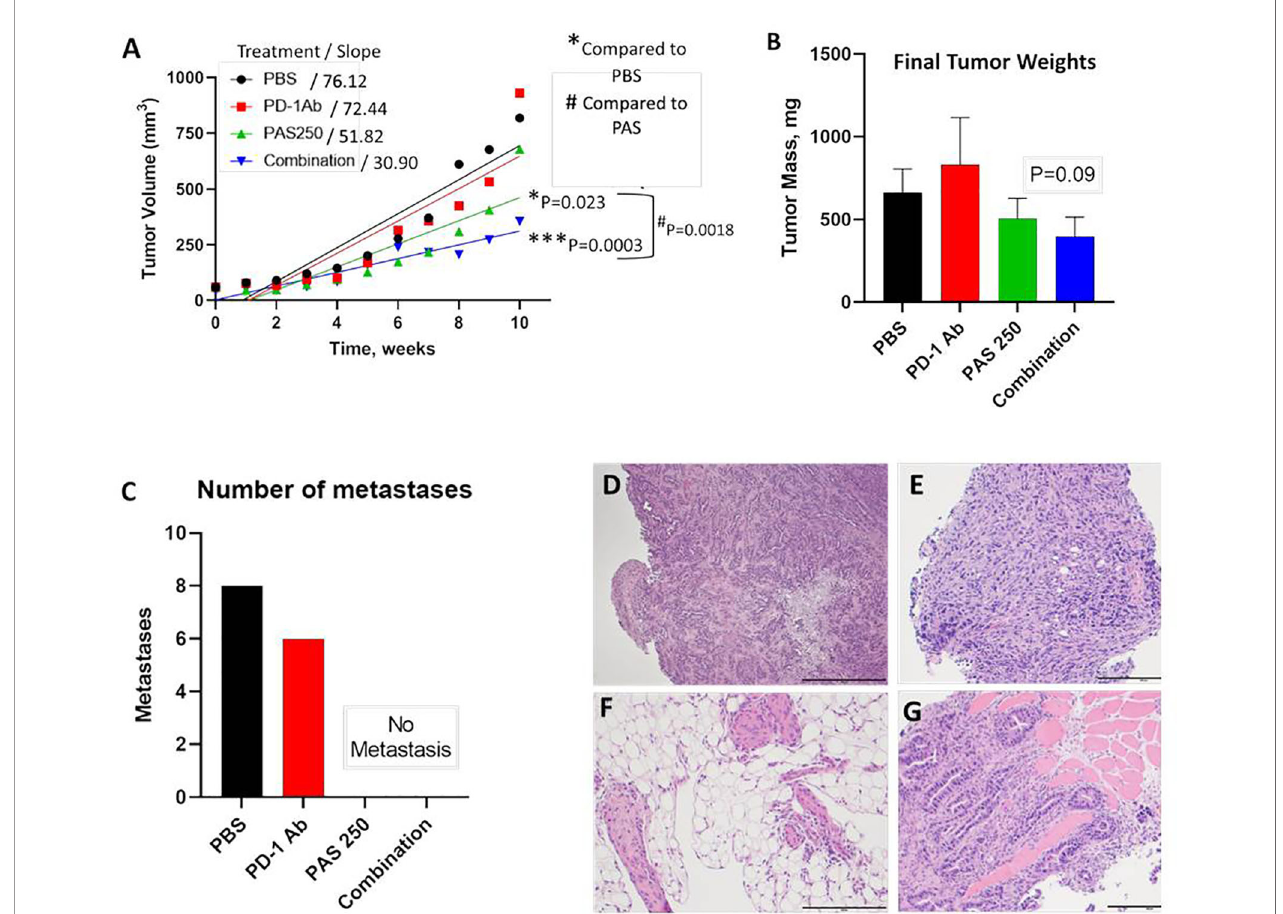
FIGURE 3 | PAS vaccination alone or in combination with PD-1 Ab inhibits growth and metastases of YTN gastric cancer tumors in mice. (A) YTN tumor volumes over time for each treatment group and respective slope of the line are shown. PD-1 Ab monotherapy did not alter rate of YTN tumor growth compared to PBS- treated controls. Tumors of mice treated with PAS monotherapy (P = 0.023) or in combination with PD-1 Ab (P = 0.0003) signi fi cantly reduced tumor growth in mice compared to PBS control treated mice. Tumors of mice treated with both PAS and the PD-1 Ab exhibited signi fi cantly smaller tumors compared to PAS monotherapy (P = 0.0018). (B) Final tumor mass ex vivo showed a reduction in size in mice treated with PAS in combination with the PD-1 Ab (P = 0.09). (C) Number of metastases for each treatment group demonstrates that metastases were only observed in Control (PBS-treated) mice and in mice treated with PD-1 Ab. No metastases were found in mice treated with PAS monotherapy or PAS in combination with the PD-1 Ab. (D – G) Metastases were con fi rmed histologically by H&E stain. (D) Invasive YTN tumor invading the stomach wall. (E) Peritoneal seeding with metastases. (F) Invasion of YTN tumor cells in the mesentery fat. (G) YTN cancer invading the abdominal wall skeletal